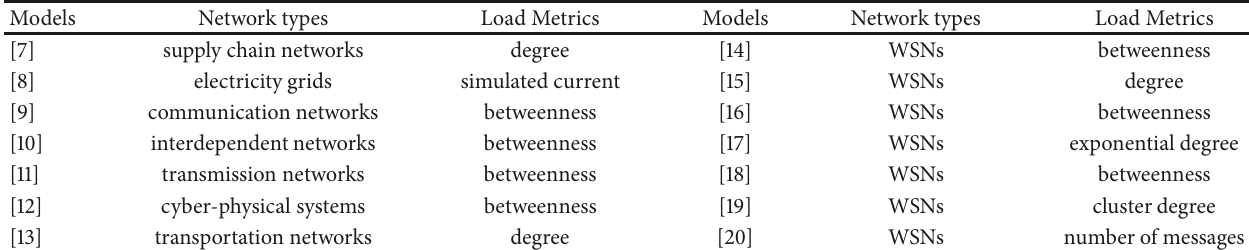
Table 1: Summary of existing cascading models.